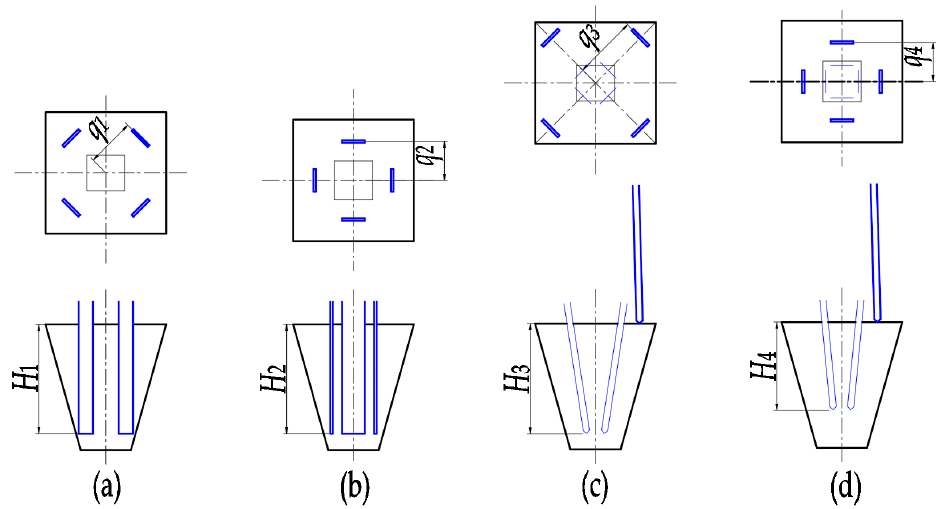
Figure 2. Diagram of clipping scheme analysis. ( a ) First inserting and then clamping, diagonally clipped. ( b ) First inserting and then clamping, four-edge clipped. ( c ) Inserting while clamping, diagonally clipped. ( d ) Inserting while clamping, four-edge clipped.